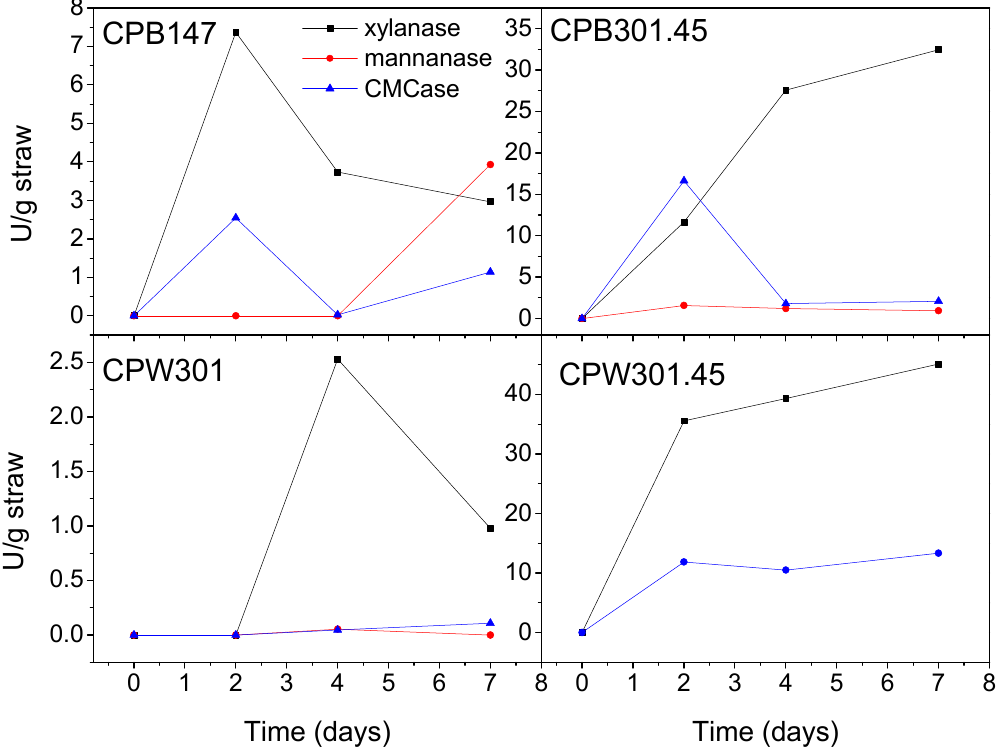
Figure 1. Enzymatic profiles for both wheat and barley straws treated under different conditions in the solid-state fermentation.